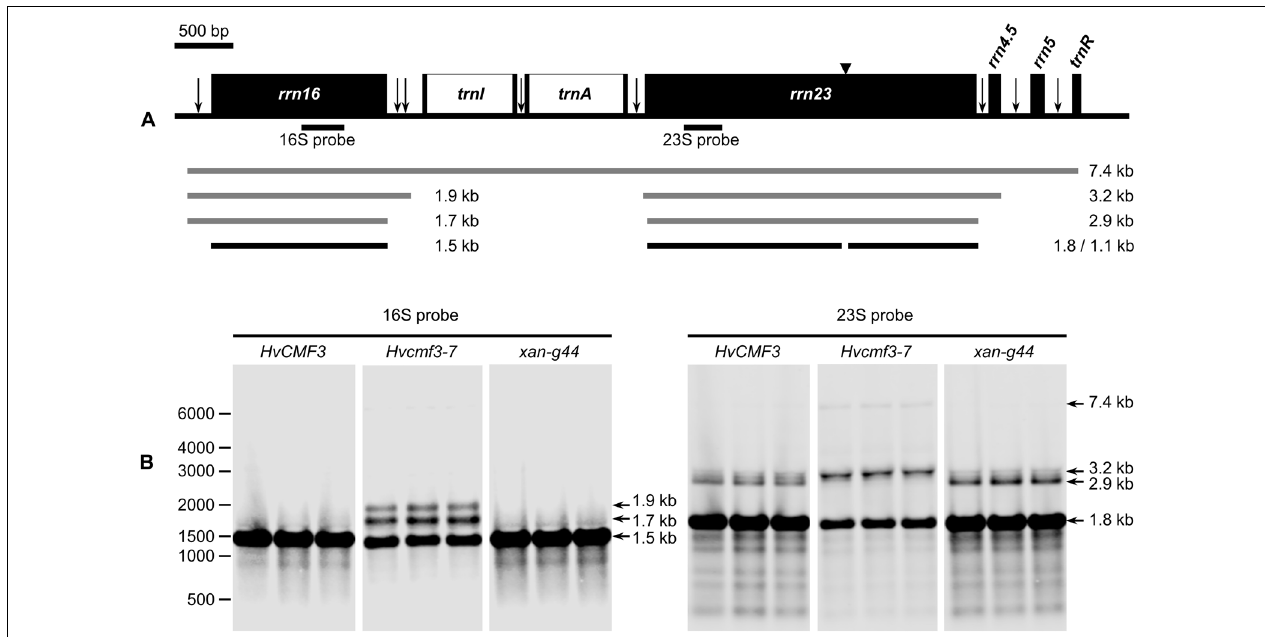
FIGURE 6 | Analysis of 16S and 23S rRNA processing in wild type, Hvcmf3-7 mutant and xan-g44 mutant. (A) Schematic representation of the chloroplast rrn operon in barley. Black boxes indicate exons and white boxes indicate introns. Vertical arrows indicate processing sites in the primary transcripts of the rrn operon. Positions of an internal cleavage site (hidden break) in the 23S rRNA is shown as black triangle. Positions of the hybridization probes for 16S and 23S are indicated below the operon structure. The 7.4-kb primary transcript and various processing precursors are shown with gray lines; the mature forms of 16S and 23S rRNAs are shown with black lines. (B) Analysis of 16S and 23S rRNA processing by RNA gel-blot. Numbers on the leftmost indicate positions of the marker bands. Arrows point to various forms of mature and precursor rRNAs mentioned in the text and shown in (A) .